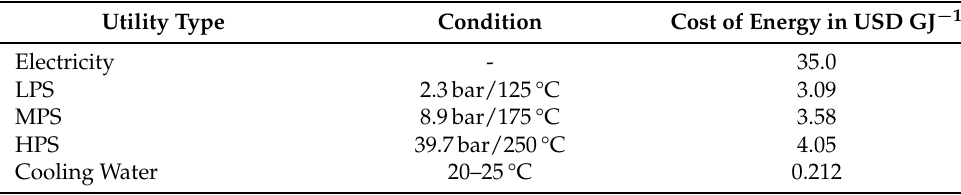
Table 1. Conditions and cost of utilities used/generated in the Bio-OCM